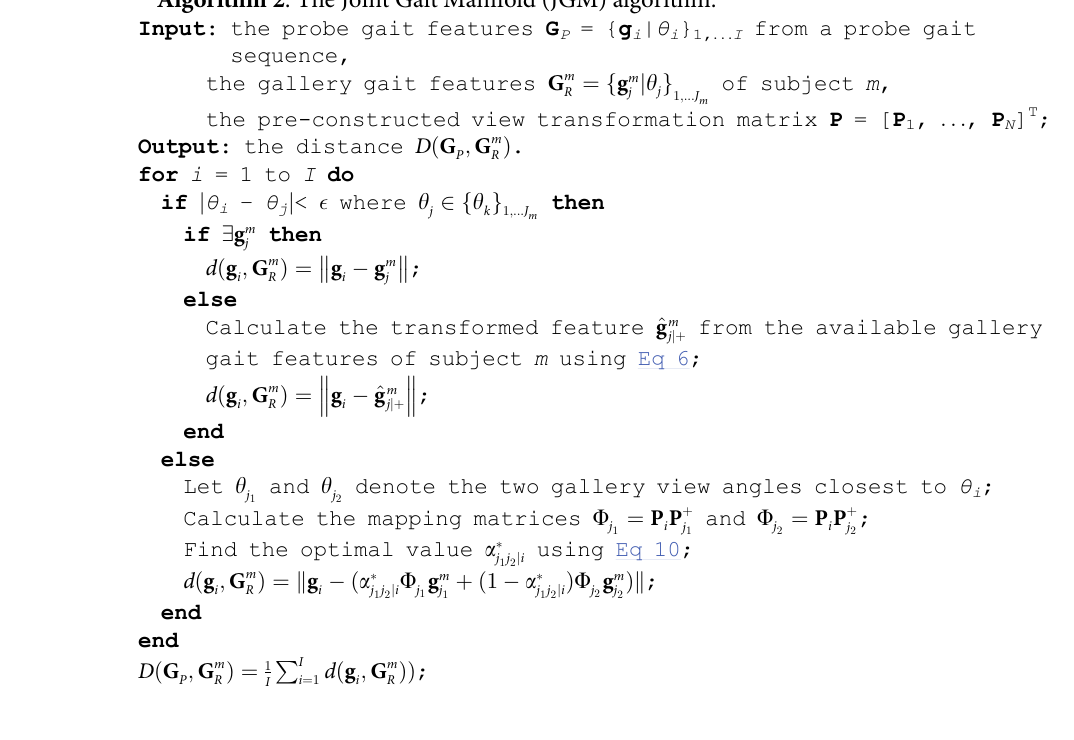
Algorithm 2 : The Joint Gait Manifold (JGM)